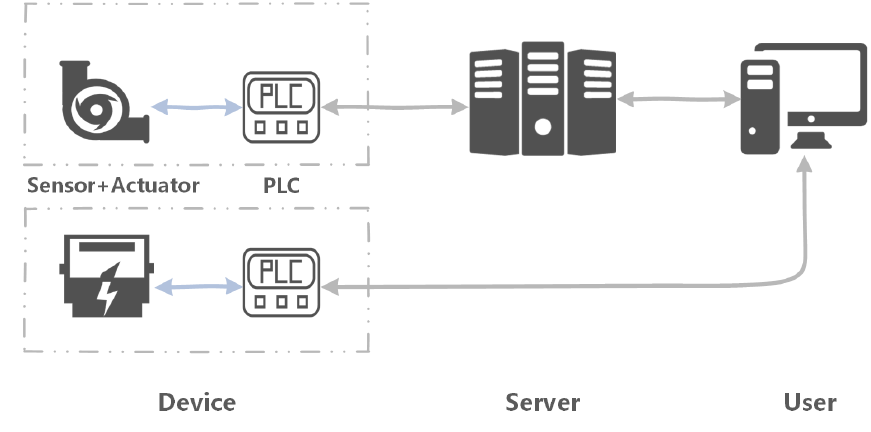
Figure 2. IoT architecture on the